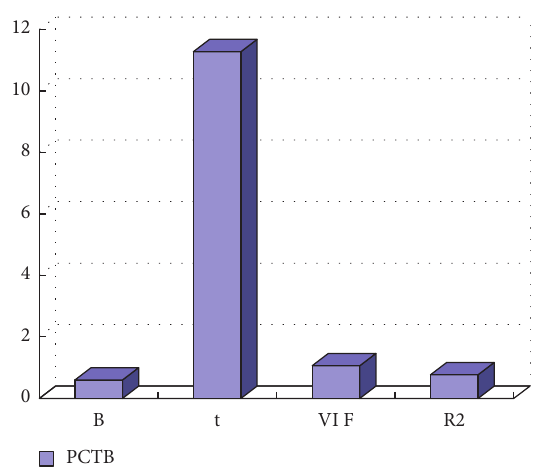
Figure 7: Regression model for TM in urban context.